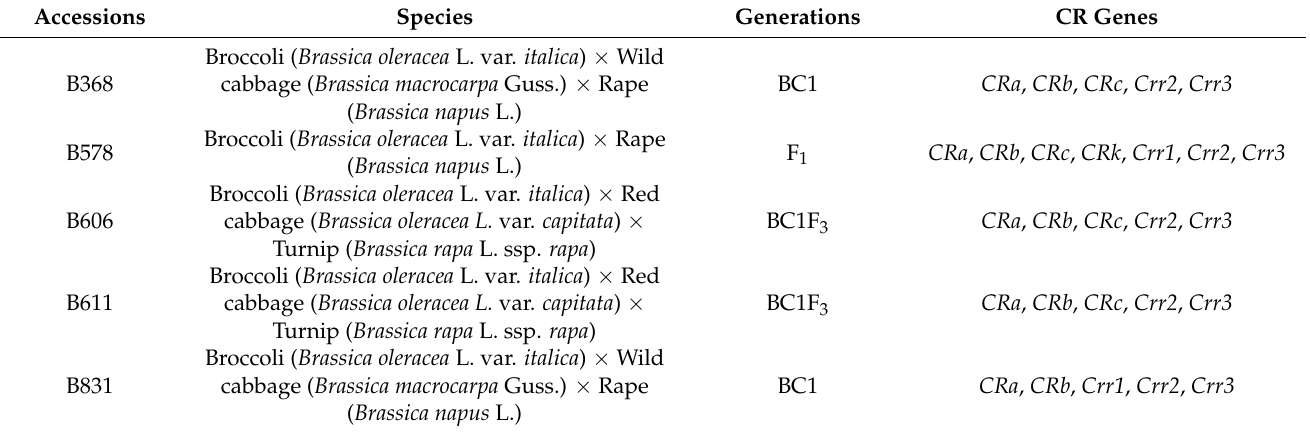
Table 1. Information on 10 broccoli genotypes resistant to